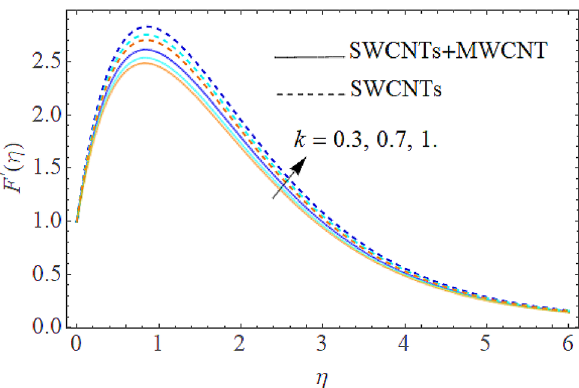
Figure 5. Influence of k on F ′ (η) .